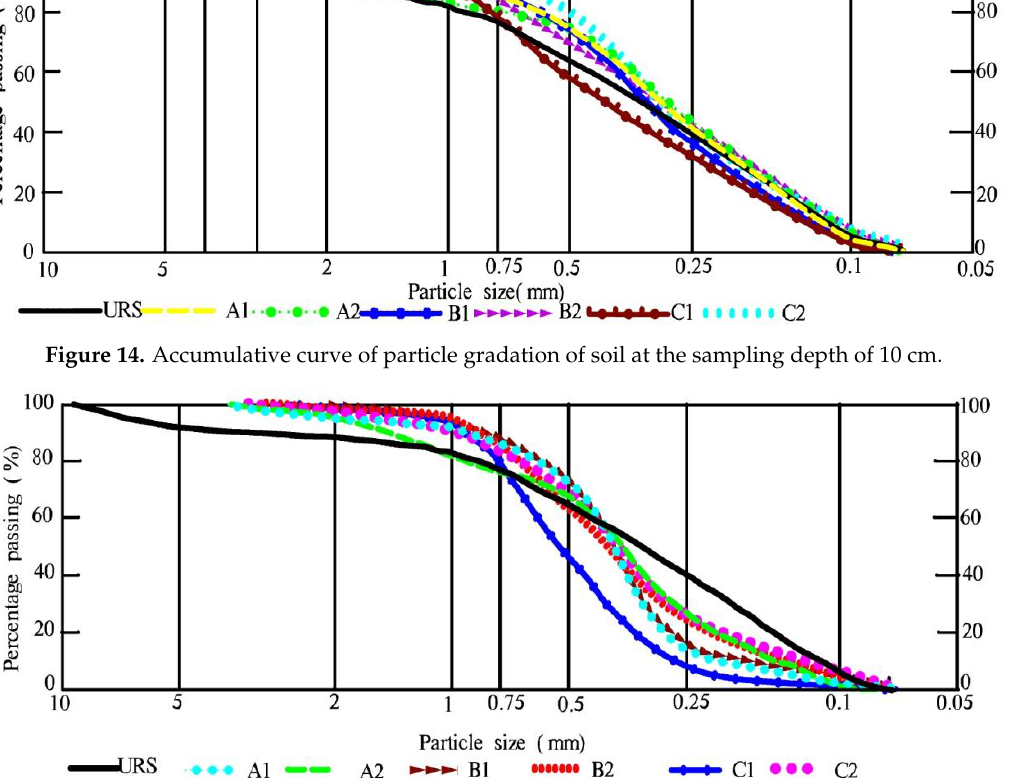
Figure 15. Accumulative curve of particle gradation of soil at the sampling depth of 30 cm.